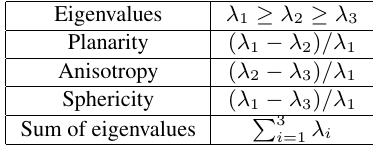
Table 1: Eigenvalue-based